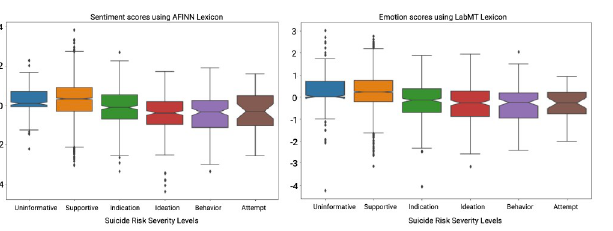
Fig 1. No significant variation in sentiment (using AFINN) and emotions (using LabMT) across suicide risk severity levels in